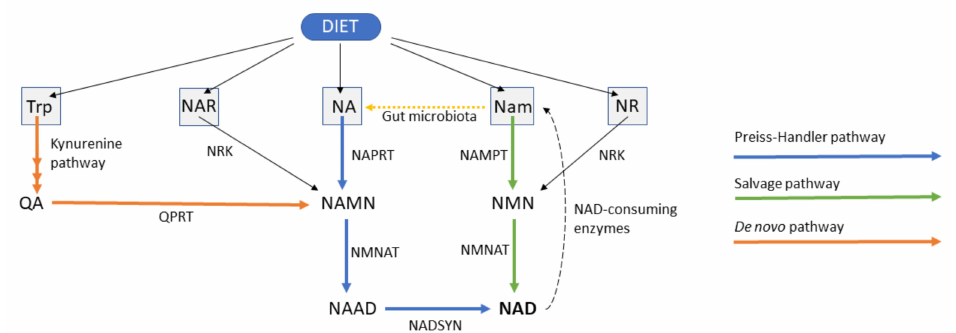
Figure 1. Graphical depiction of NAD biosynthesis in mammals. Trp, tryptophan; NA, nicotinic acid; NAR, nicotinic acid riboside; NR, nicotinamide riboside; Nam, nicotinamide; QA, quino- linic acid; NAMN, nicotinic acid mononucleotide; NMN, nicotinamide mononucleotide; NAAD, nicotinic acid adenine dinucleotide; NAD, nicotinamide adenine dinucleotide; QPRT, quinolinate phosphoribosyltransferase; NAPRT, nicotinate phosphoribosyltransferase; NAMPT, nicotinamide phosphoribosyltransferase; NRK, nicotinamide riboside kinase; NMNAT, nicotinamide mononu- cleotide adenylyltransferase; NADSYN, nicotinamide adenine dinucleotide